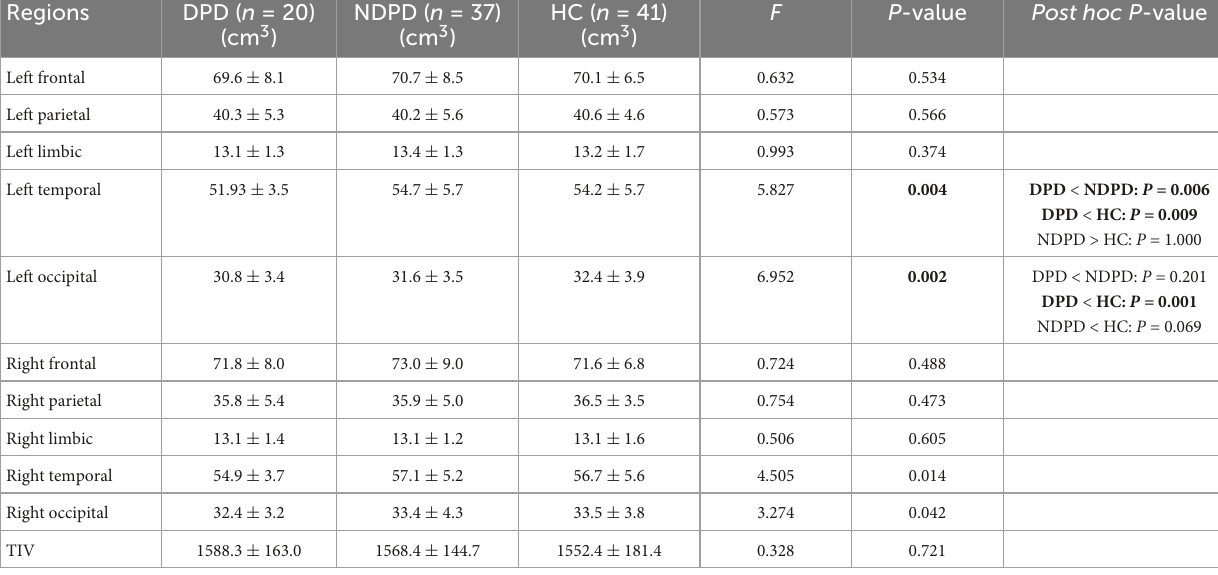
TABLE 4 The differences of cortical GM volumes of PALS_B12 lobes among three groups. Regions